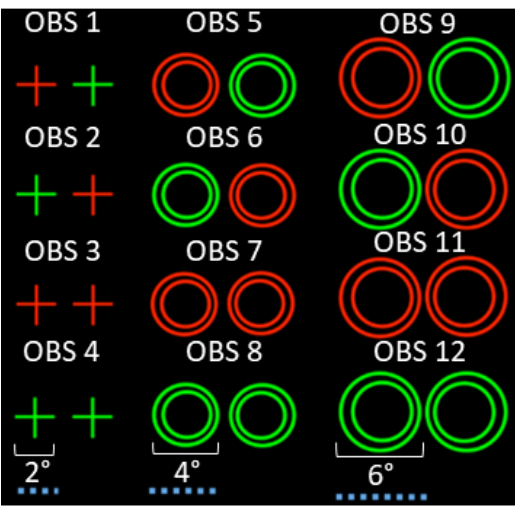
Figure 1: A) Stimulus design used for the 12 observation (OBS) with respect to visual target and